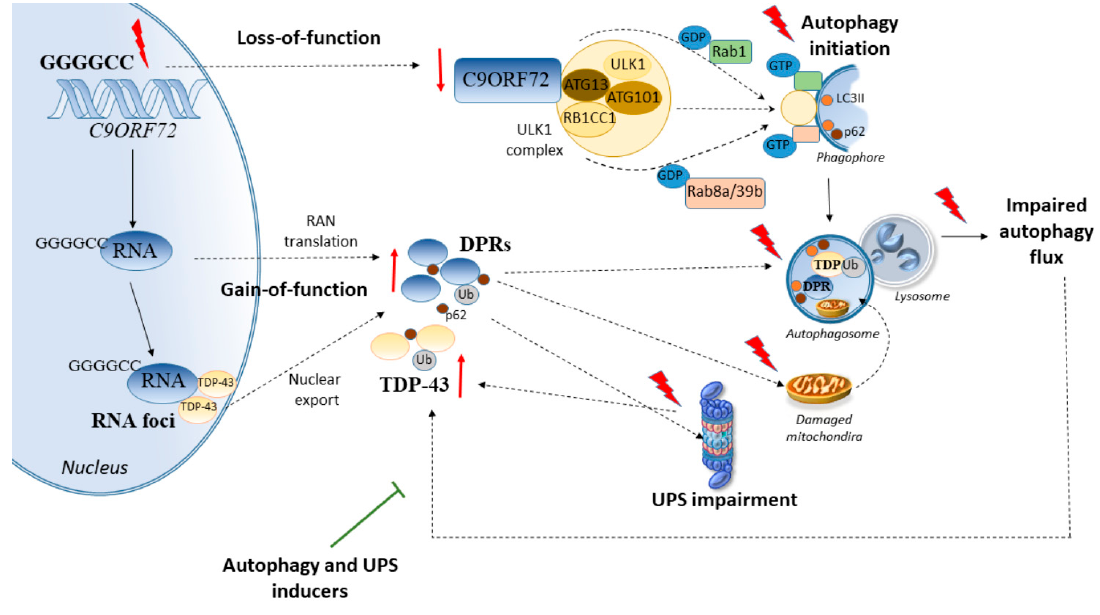
Figure 1. Chromosome 9 open reading frame 72 ( C9ORF72 ) repeat expansions alter autophagy and the ubiquitin proteasome system (UPS) through a combination of loss- and gain-of-function mechanisms. Reduced C9ORF72 levels due to GGGGCC expansions may synergize with dipeptide repeat (DPR)-dependent gain of toxicity through autophagy and UPS deficits. In detail, C9ORF72 loss-of-function impairs autophagy initiation by hampering the recruitment of Rab1, Rab8 / 39, and ULK1 complex to the phagophore. At the same time, through a gain-of function mechanism, C9ORF72 repeat expansions lead to the formation of DPR proteins through a repeat-associated non-AUG (RAN) translation and / or through formation of RNA foci that sequester proteins such as TAR DNA-binding protein 43 (TDP-43) which are exported from the nucleus to the cytoplasm. This leads to the formation of cytosolic protein aggregates that alter mitochondria and impair the UPS while engulfing autophagy compartments. A failure in autophagy flux along with UPS catalytic activity eventually promotes further DPR protein and TDP-43 aggregation, which can be prevented by autophagy or UPS inducers. Flashlights indicate mutations or alterations.